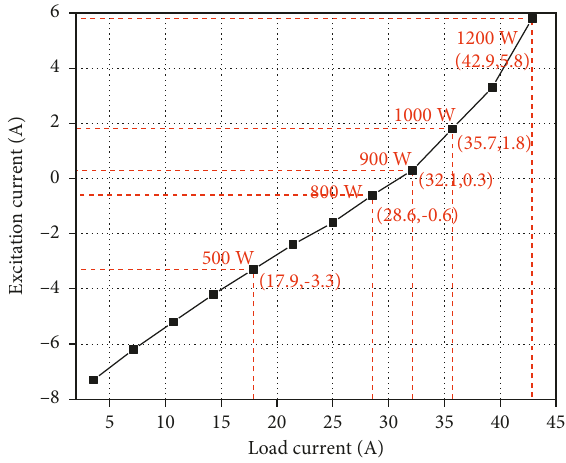
Figure 28: The regulation characteristic curve of the